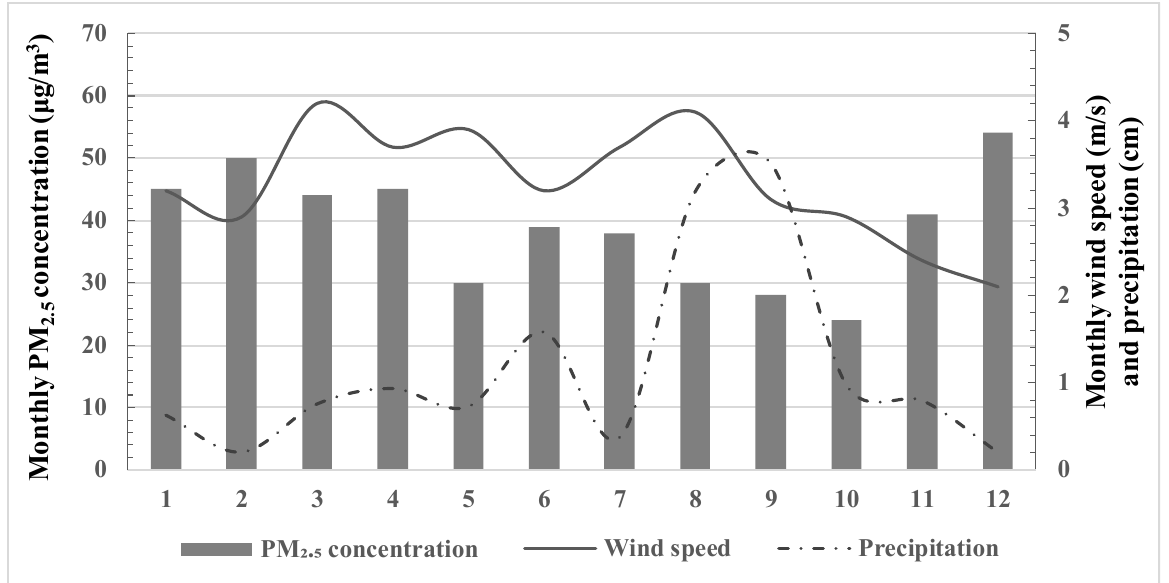
Figure 2. Monthly PM 2.5 concentration, wind speed, and precipitation in Shanghai.